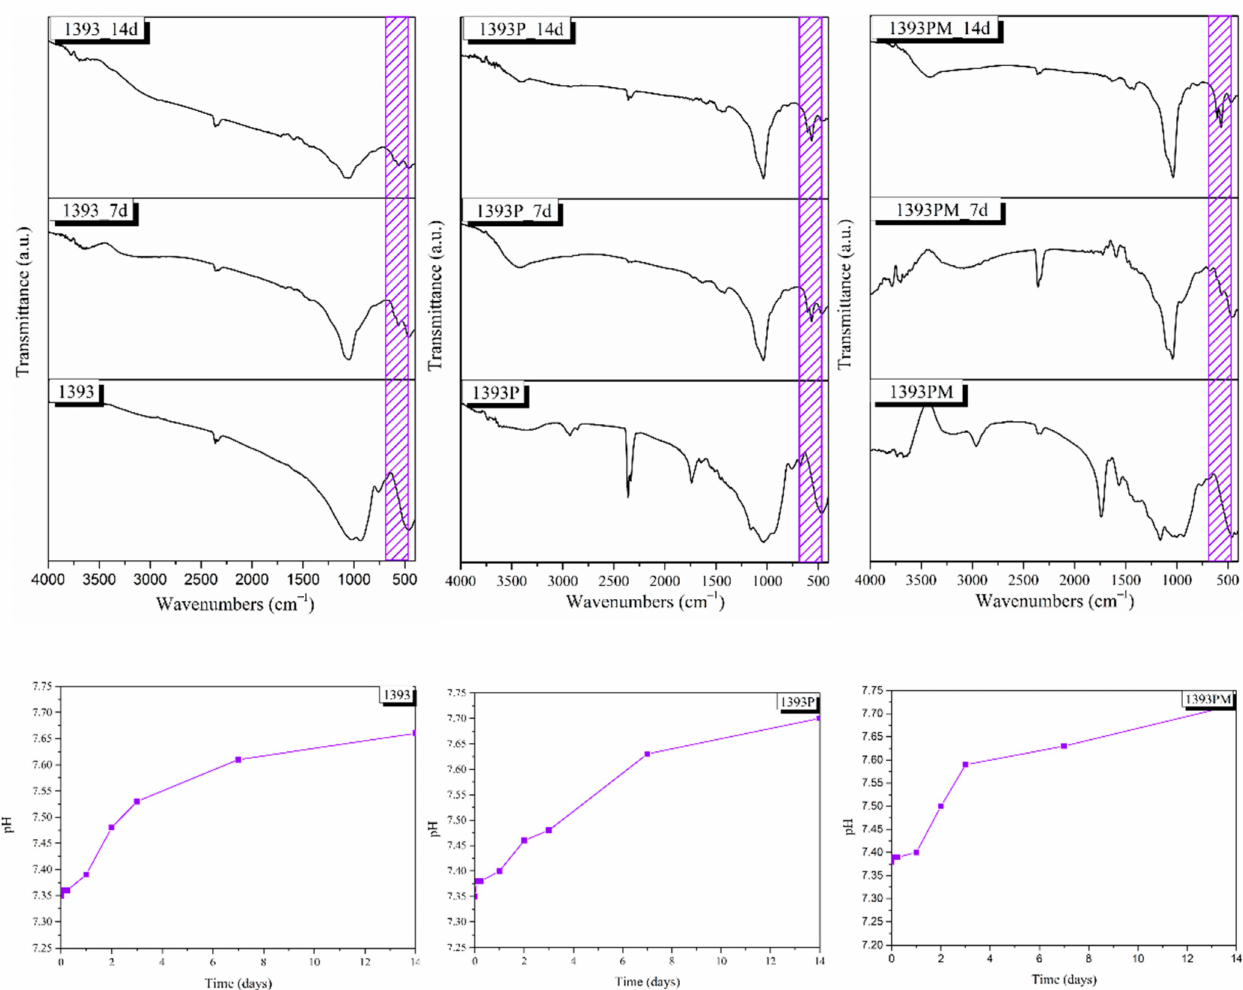
Figure 10. FTIR spectra of all scaffolds after 0, 7 and 14 days of immersion in SBF, and respective pH change. The shaded purple area reveals the presence of the double peak corresponding to the P–O bending